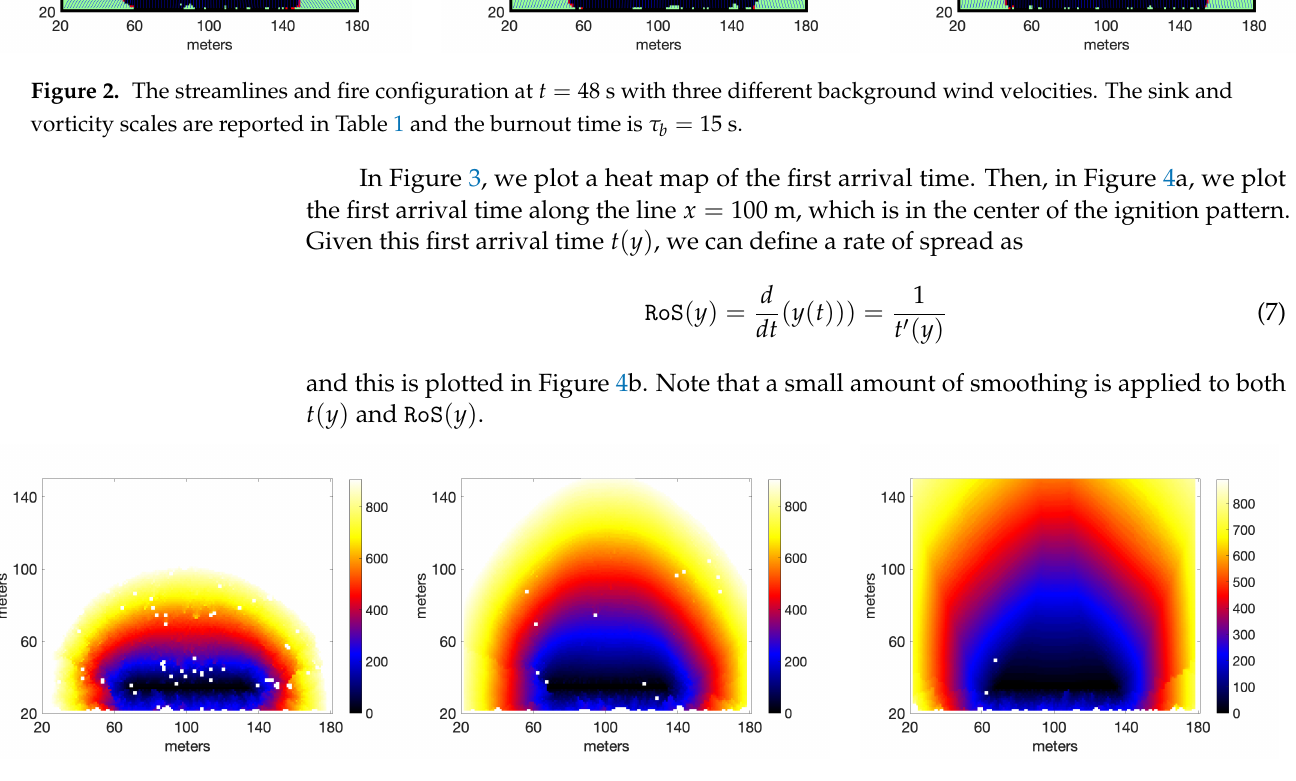
Figure 3. The first arrival time, in seconds, using the same parameters as Figure